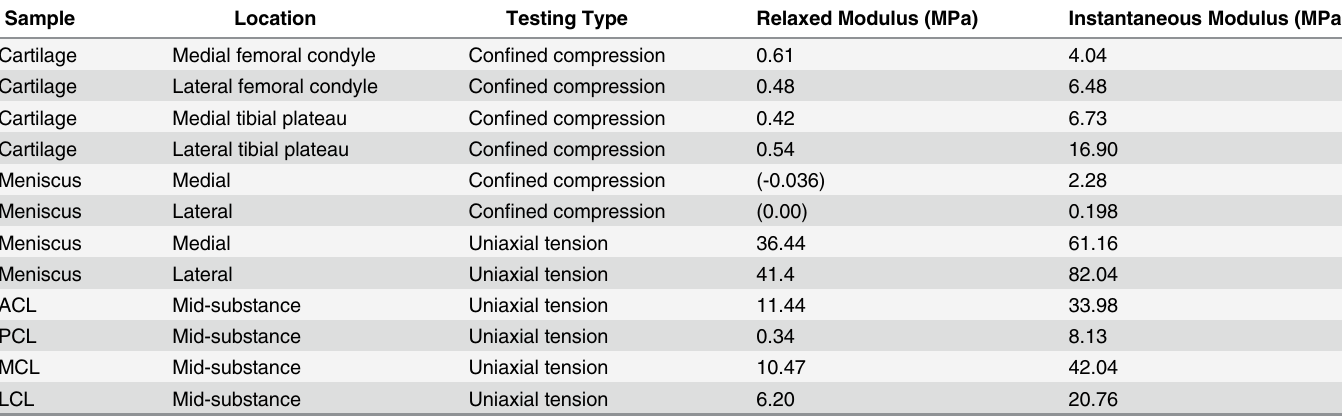
Table 2. Moduli of all tissue samples for the linear region of the stress-strain response, for instantaneous and relaxed states.